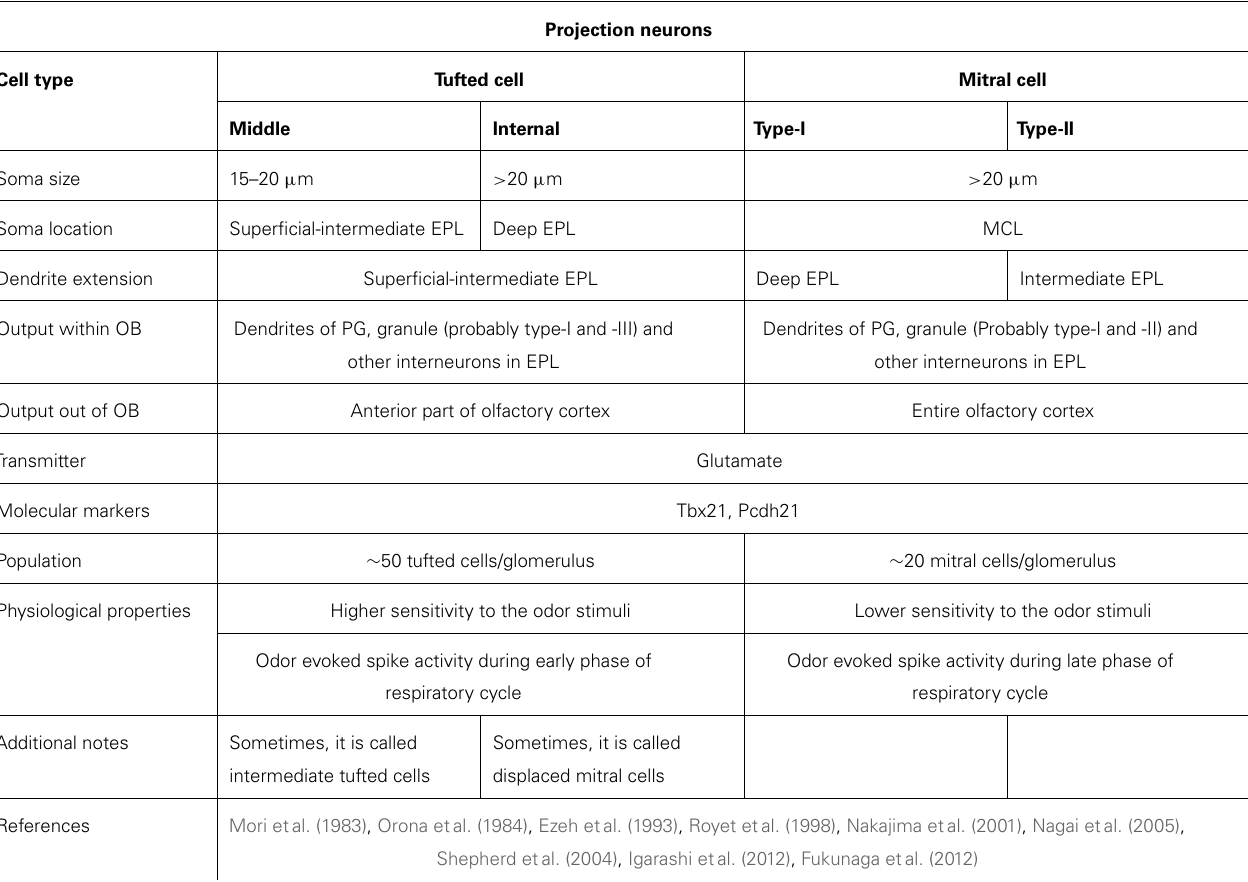
Table 2 | External plexiform layer and mitral cell